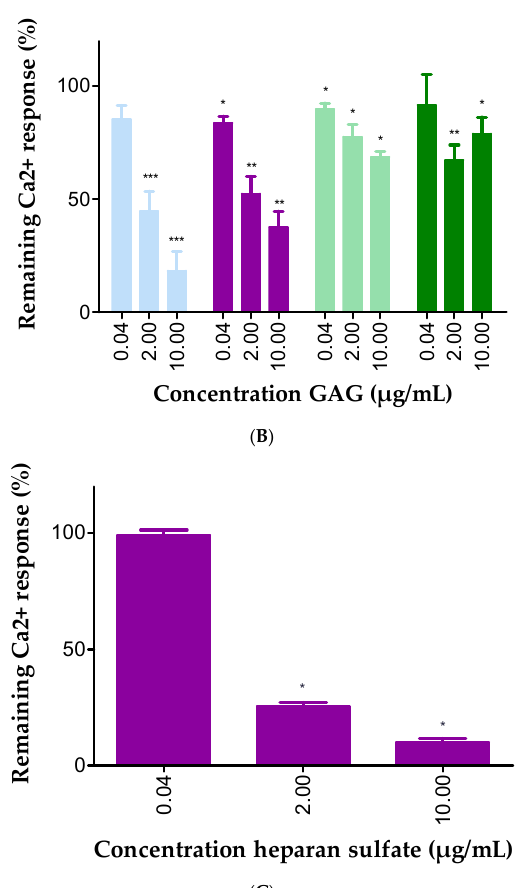
Figure 4. GAGs interfere with chemokine signaling through CXCR3. CHO/CXCR3A cells were stimulated with 3 ng/mL: CXCL10 ( A ); or CXCL11 ( B ); or 1 µg/mL CXCL9 ( C ) in the presence or absence of heparan sulfate (violet, ● ), heparin (light blue, ● ), heparin DP30 (blue, ● ), heparin DP8 (deep blue, ● ), dermatan sulfate (red, ● ), chondroitin sulfate A (light green, ● ) or chondroitin sulfate C (green, ● ). [Ca 2+ ] i concentrations were calculated using the equation of Grynkiewicz et al. Mann– Whitney U-tests were performed to statistically compare [Ca 2+ ] i concentrations obtained after stimulation with CXCL9, CXCL10 or CXCL11 plus GAG, with [Ca 2+ ] i concentrations that resulted from stimulation with, respectively, CXCL9, CXCL10 or CXCL11 only (* = p < 0.05; ** = p < 0.01; *** = p < 0.001). Results are represented as mean percentages (±SEM) compared to conditions in which cells were stimulated with CXCL9, CXCL10 or CXCL11 without GAG. Percentages are means of 3–8 independent